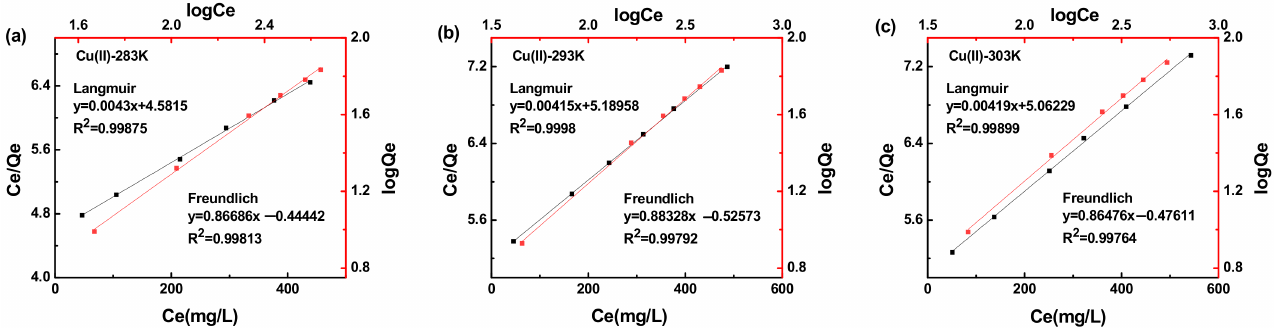
Figure 9. Adsorption isotherms for Cu(II) ions on MXCS/PAA at 283 K ( a ), 293 K ( b ), and 303 K ( c